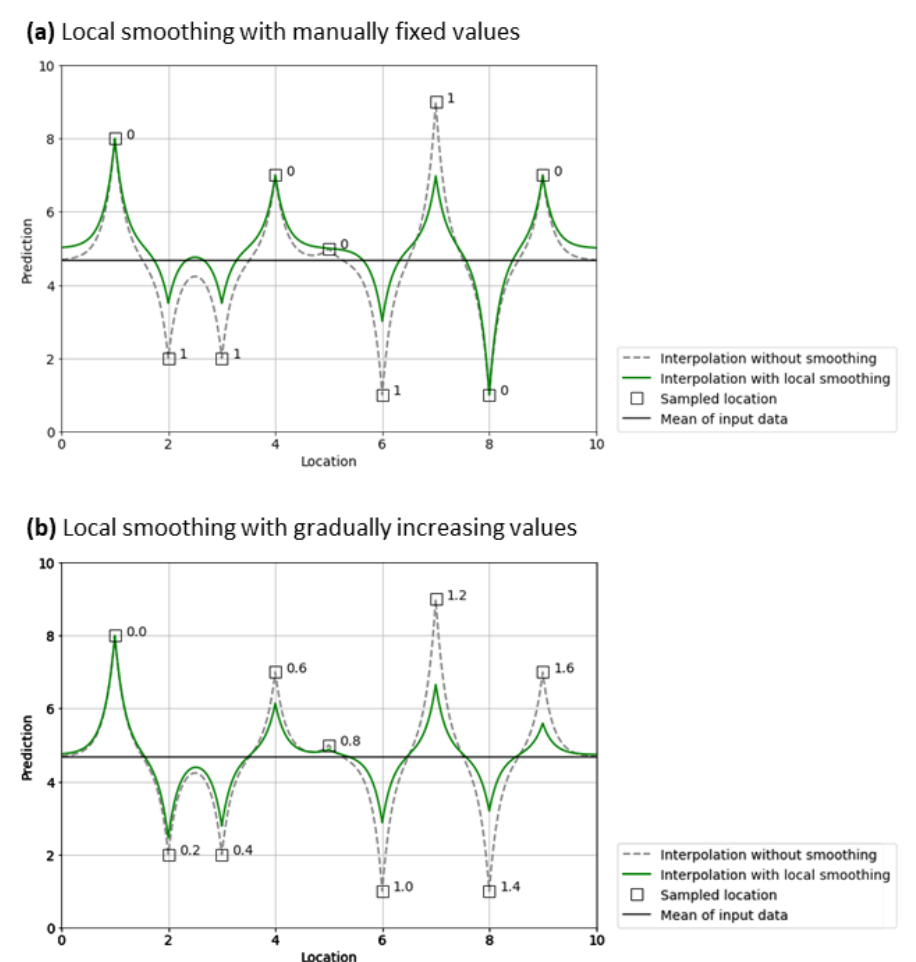
Figure 4. Application of local smoothing to 1D Ordinary kriging interpolation using an exponential model with range = 0.2 and sill = 1. Assigned local smoothing values noted next to sampled data locations. ( a ) Manually fixed local smoothing (either 0 or 1). ( b ) Local smoothing gradually increasing as function of location (from left (0) to right